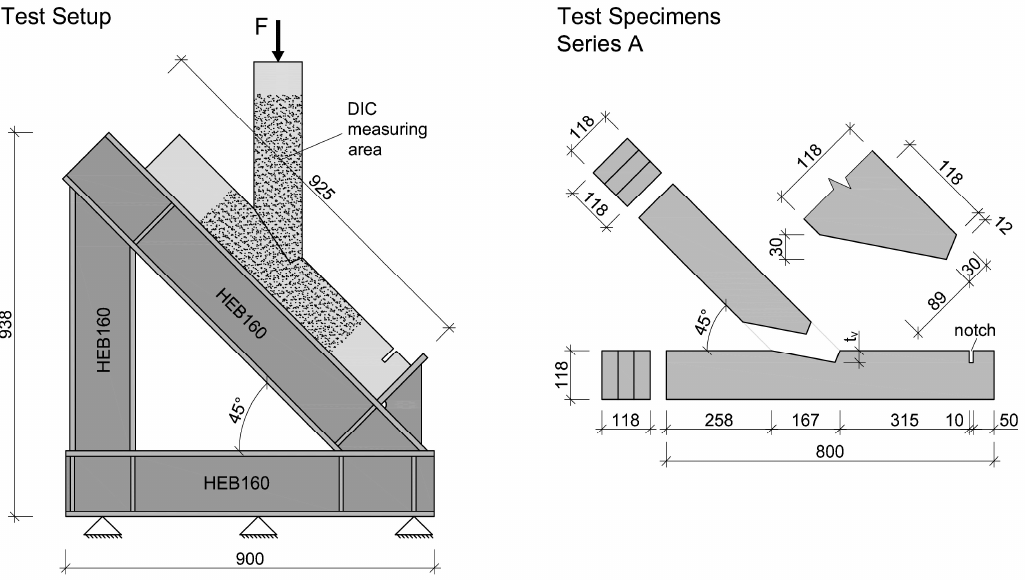
Figure 1. ( Left ): Test setup [4]; ( Right ): Geometry of the Series A test specimens. Measurements in